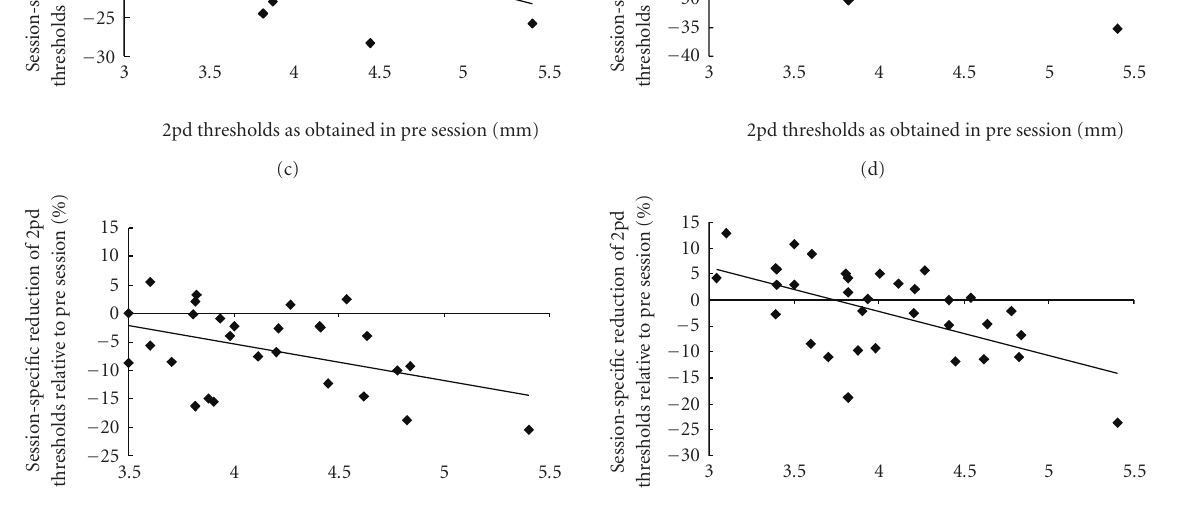
SESSION and GROUP (repeated measures ANOVA) for averaged d-prime values of the subjects’ right hand ( F (6,54) = 10 . 443, P ≤ . 001) . Averaged d-prime values of the subjects in the target group were 1 . 18 ± 0 . 08 in the pre session . After starting the intervention this value increased significantly (Dunnett posthoc test) to 1 . 26 ± 0 . 15 ( P ≤ . 001) in session post , 1 . 34 ± 0 . 05 ( P ≤ . 001) in post-w2 , 1 . 34 ± 0 . 06 ( P ≤ .